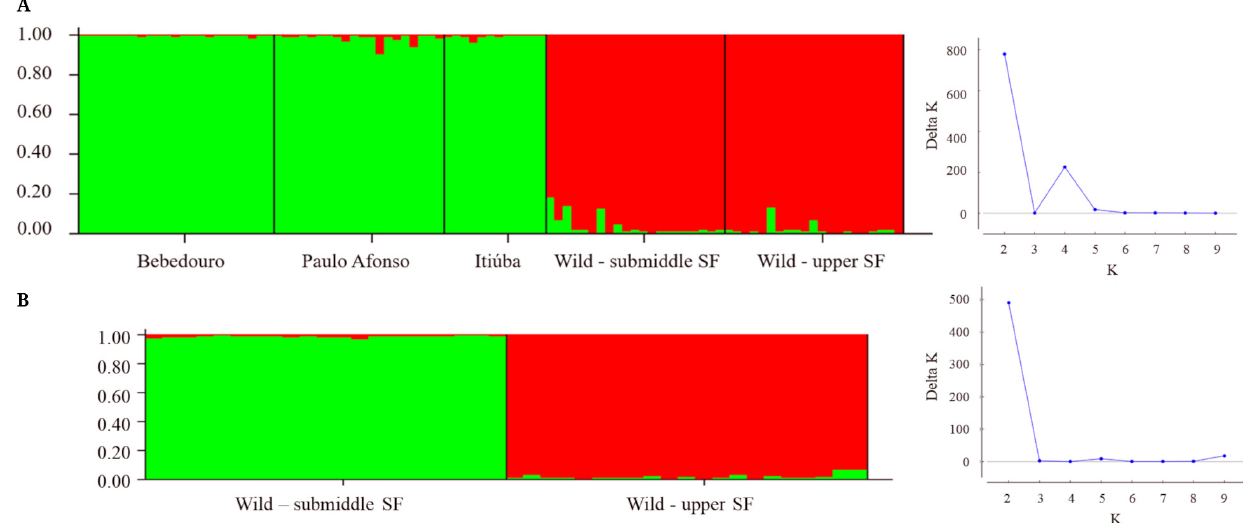
FIGURE 2 | Attributions of Lophiosilurus alexandri genotypes from A. captive broodstocks (Bebedouro, Paulo Afonso, and Itiúba) and wild samples taken from two stretches of the São Francisco River (upper and submiddle) and B. only for the wild samples. Each vertical bar represents a different individual and the length is proportional to the inferred group, cluster 1 (red) and cluster 2 (green). Respective estimated K value through log-likelihood. Y axis for delta (K) values and X axis for different K values